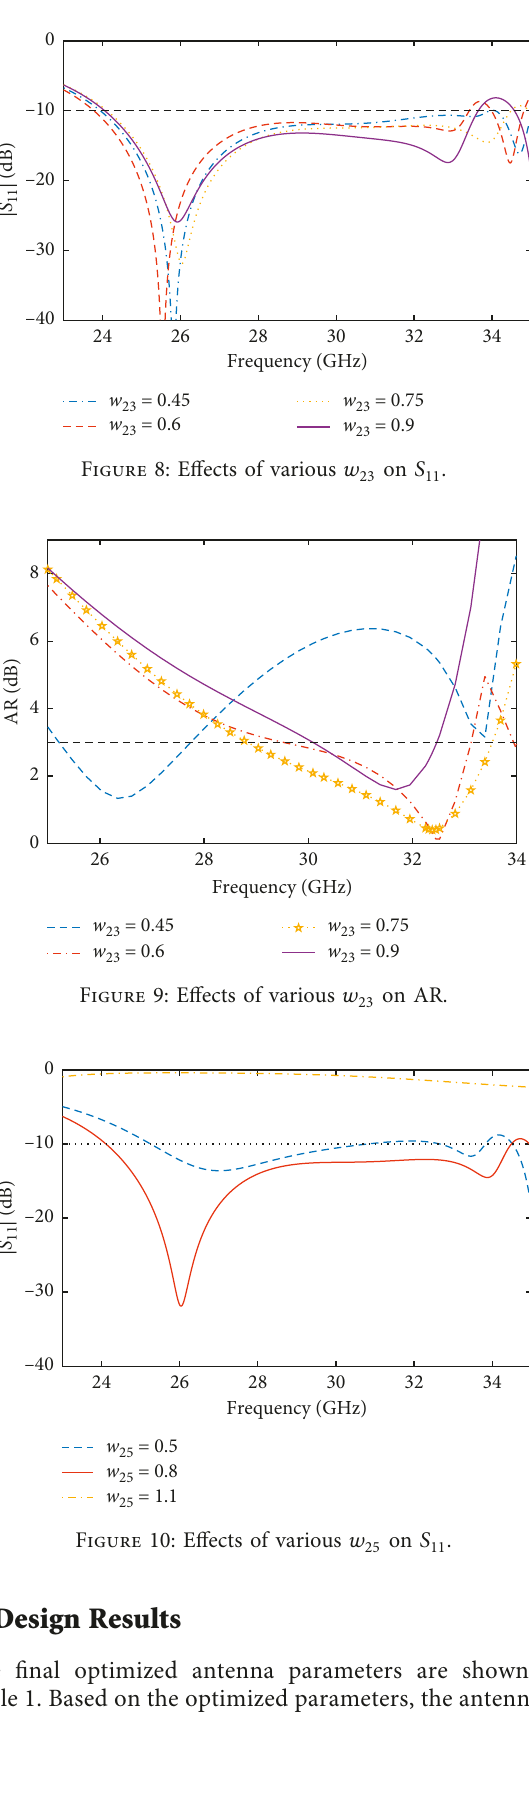
Figure 7: Effects of various w